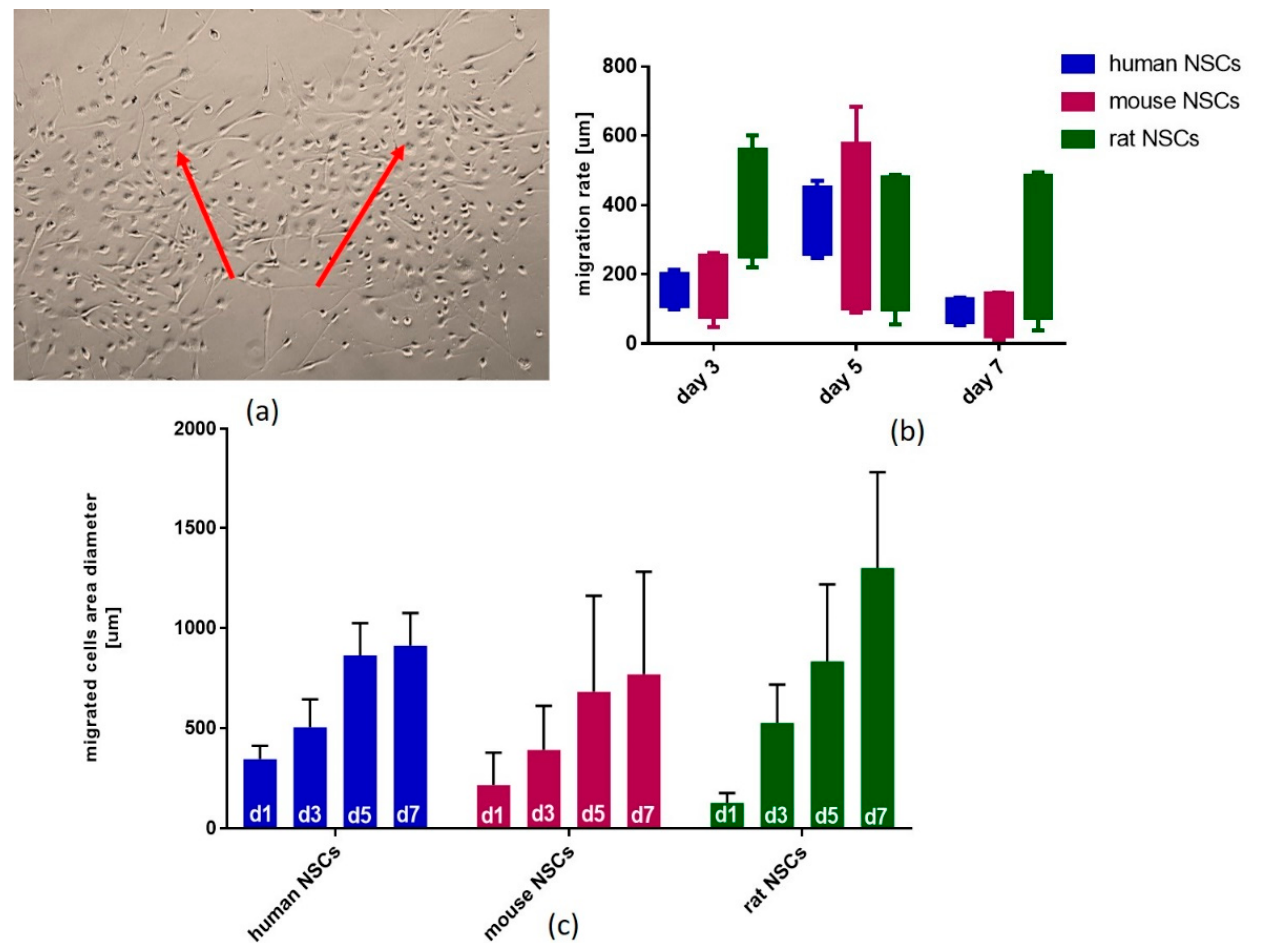
Figure 15. The migratory properties of the human, mouse, and rat NSCs. ( a ) Microscopic view of migrating human NSCs from 2 neurospheres (red arrows). ( b ) Migration rate of human, mouse, and rat NSCs on Days 3 (d3), 5 (d5), and 7 (d7) of culture. ( c ) Migrated cells’ area on Days 1, 3, 5, and 7 (d1, d3, d5, and d7, respectively). Cell culture conditions: 5% O 2, 5% CO 2 , 37 °C. N = 3.